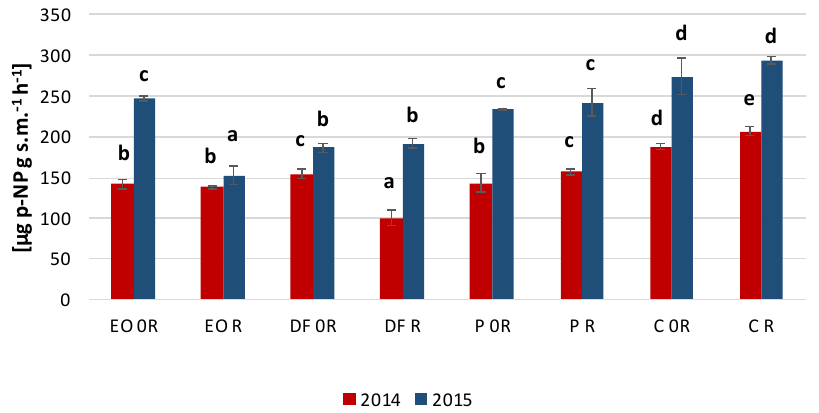
Figure 2. Acid phosphatase activity after four (2014) and five (2015) years from soil contamination and the use of ZB-01. Mean values marked with the same letters for each year separately do not differ significantly according to the LSD test at p < 0.05. Symbols are the same as those given in Figure 1. Vertical bars show mean ± SE. and depended on the type of contamination, the type of enzyme analyzed, and the year of study. The biopreparation applied to EO-contaminated soil led to reduced dehydro- genase and urease activity four years after soil contamination as compared to that in the control soil. On the other hand, it caused an increased dehydrogenase activity after five years (by nearly 35 µg TPF g d.m. − 1 16 h − 1 ). In the DF-contaminated soil, the biopreparation caused an increase in alkaline phosphatase activity four years after soil contamination by approximately 35%, while also causing a decrease in acid phosphatase and urease activity. The application of the biopreparation to P-contaminated soil decreased alkaline phospha- tase activity four and five years after soil contamination by nearly 20% and increased ure- ase activity, but only in 2014. In the control section, the biopreparation usually increased the activity of the analyzed soil enzymes, except alkaline phosphatase.